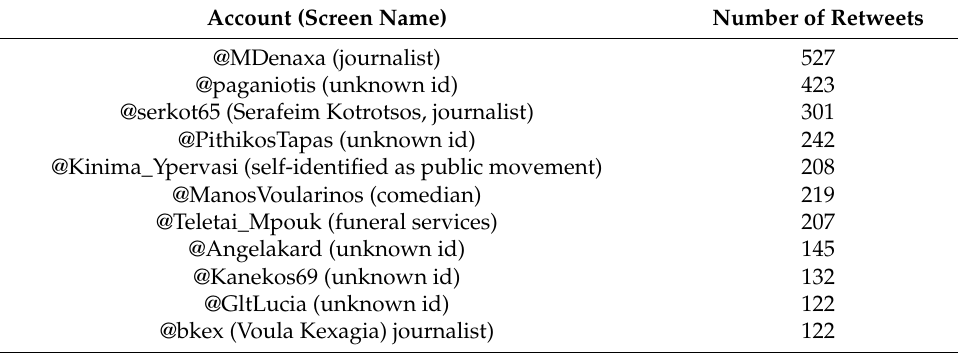
Table 5. Most popular accounts by number of retweets.